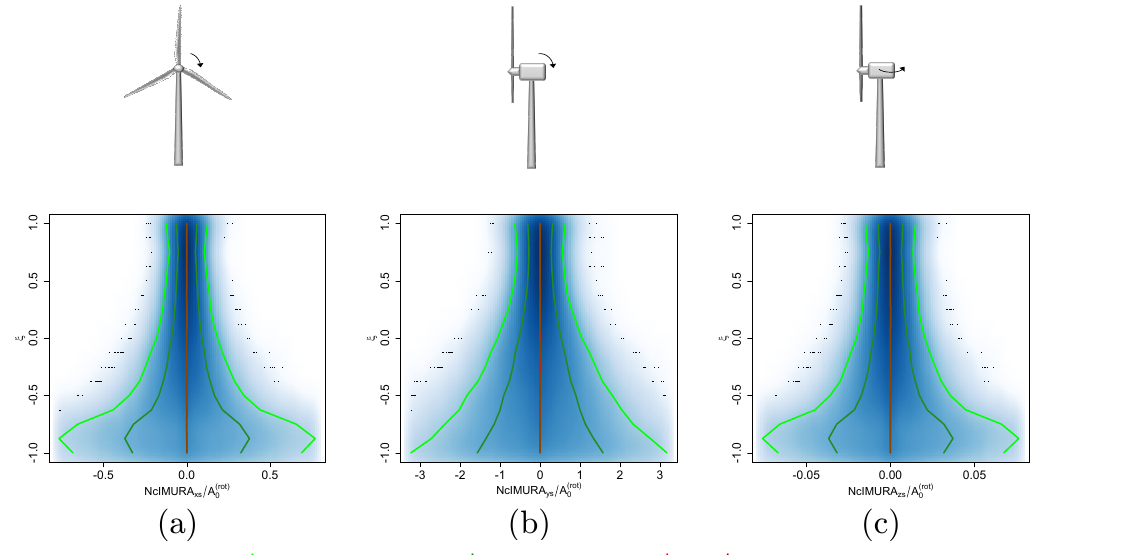
Figure 4. Variation with ξ of the PDFs of the nacelle’s angular accelerations. (a) Around rotor axis. (b) Around cross axis. (c) Around vertical axis. The parameter ξ is represented by the vertical axis, starting with an entirely positive shear at the bottom (where ξ = − 1) and ending with an entirely negative shear at the top (where ξ = 1). The horizontal axis represents values of the nacelle’s angular accelerations (NcIMURA) normalized by a reference ( A (rot) ). The background color is deeper where values are more concentrated. The red line and the 0 dark red line connect the mean and the median values, respectively. The green lines and the dark green lines delimit the zones encompassing 95 and 68% of the values, respectively.